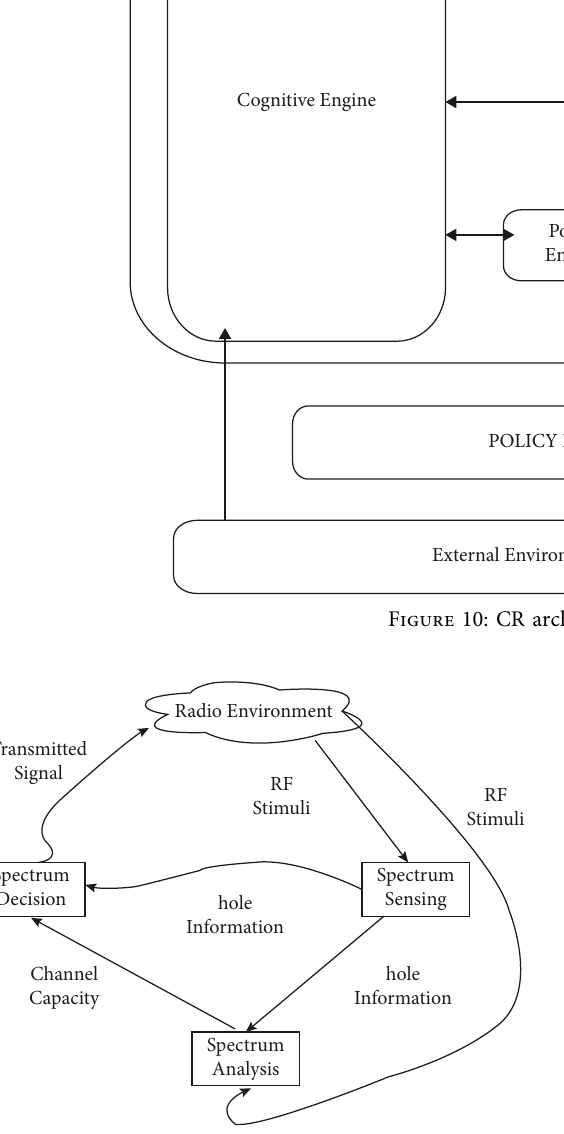
Figure 11: Basic cognition